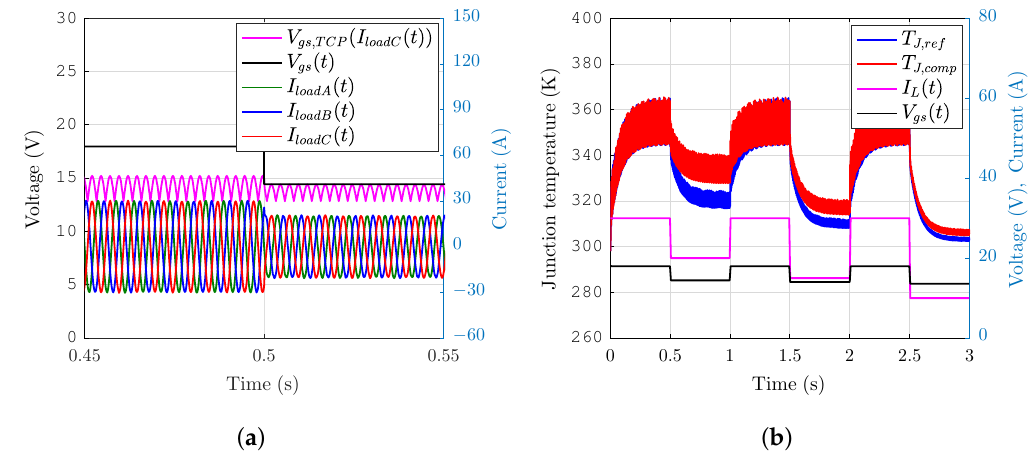
Figure 6. Simulation results of ( a ) Gate voltage profile and three-phase load current, and ( b ) Junction temperature response of switch Cu under high speed operation condition.